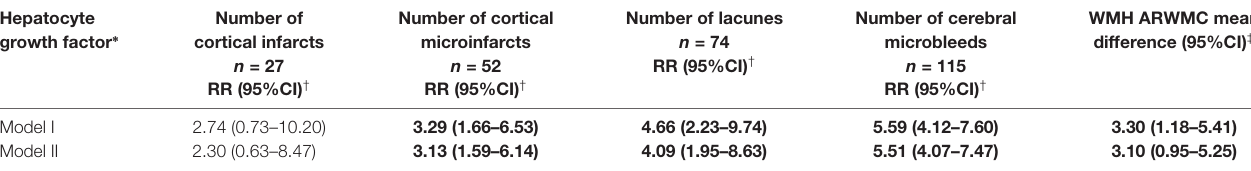
TABLE 3 | Association of HGF with magnetic resonance imaging (MRI) markers of cerebrovascular disease (CeVD) in CIND and AD.